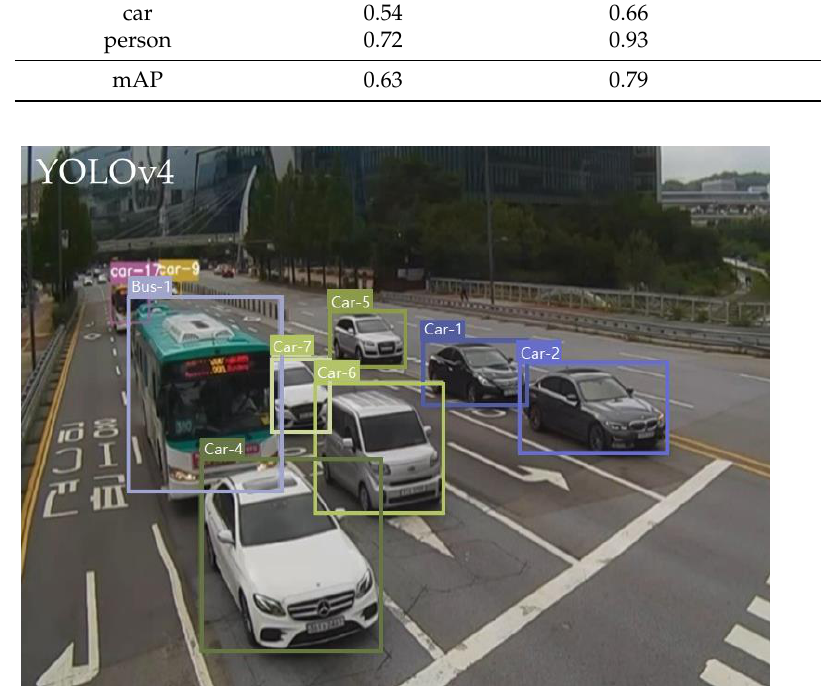
Figure 11. Results of detection using our